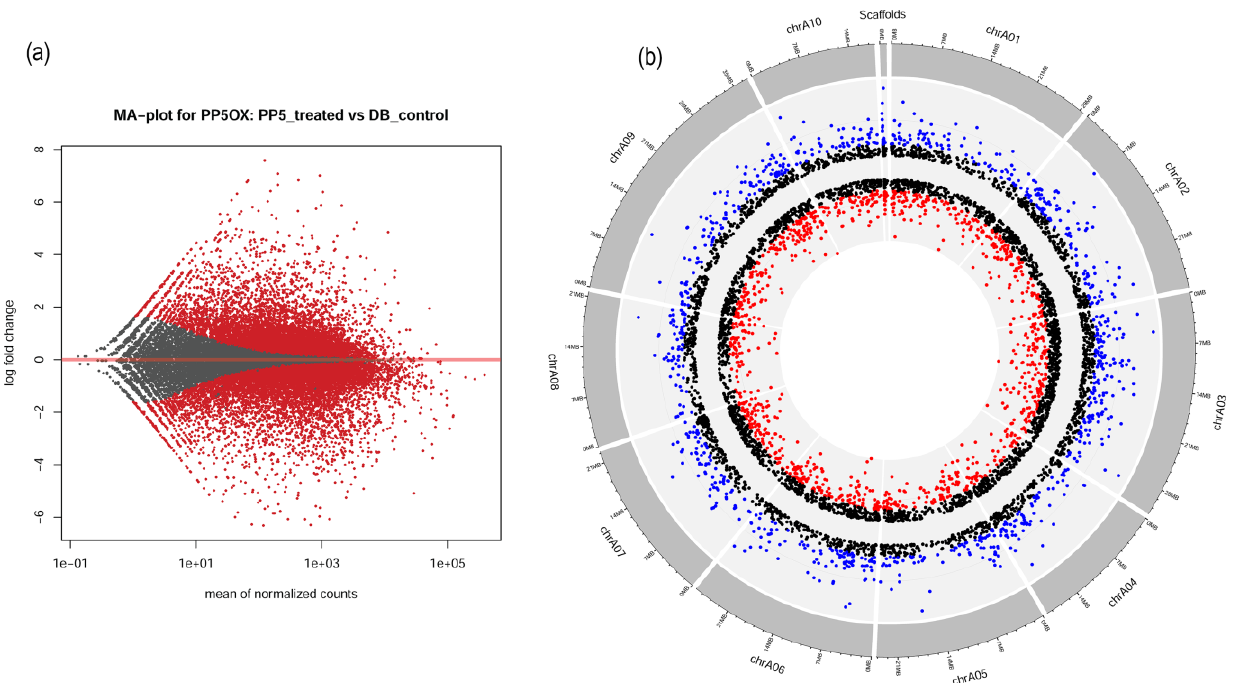
Figure 3. The transcriptomic signatures of BrPP5.2 overexpressing transgenic B. rapa lines. ( a ) The MA plot represents the differentially expressed genes (DEGs) (FDR < 0.05) derived from RNA sequencing data of transgenic lines compared to those of non-transgenic controls. ( b ) The circus plot depicts DEGs across the 10 B. rapa chromosomes. The color codes represent the significance levels of DEGs. The red spots indicate the downregulated DEGs (logFC ≤ | − 2|; FDR < 0.05), and blue spots (logFC ≥ |2|; FDR < 0.05) represent the upregulated DEGs in BrPP5.2OX lines, while black spots represent the non-significant DEGs observed in differential gene expression analysis between transgenic and control lines.